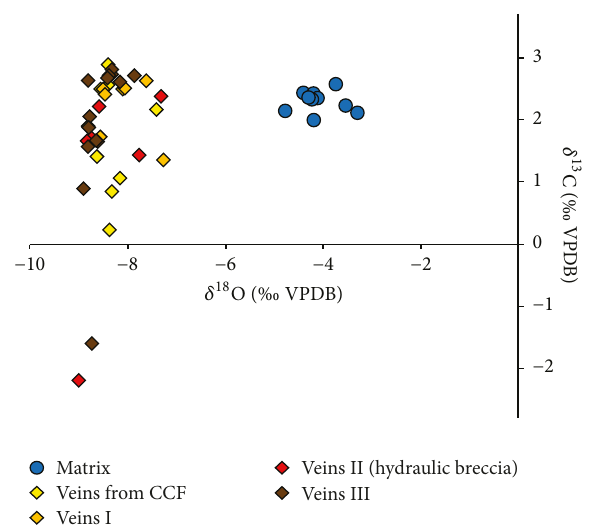
Figure 5: 𝛿 13 C versus 𝛿 18 O cross plot of the calcite veins and chalk matrix (host rock and breccia fragments) from Flamborough Head (UK). Matrix and veins display distinct signatures, while different vein generations display similar